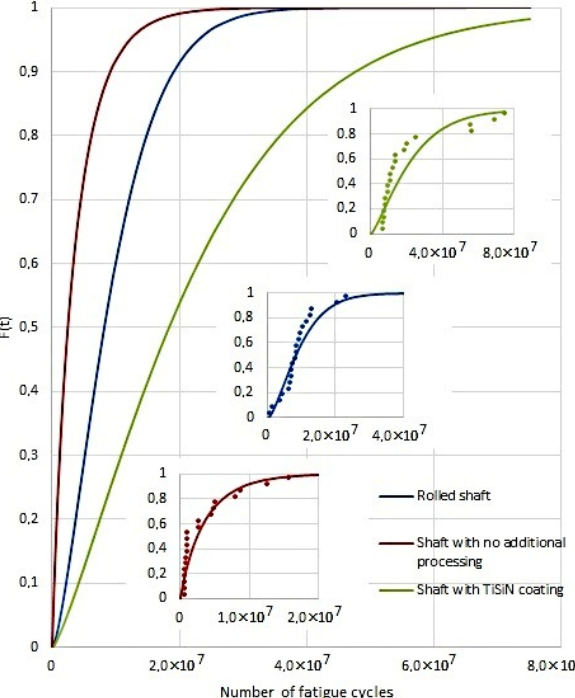
Figure 6. Cumulative distribution function.